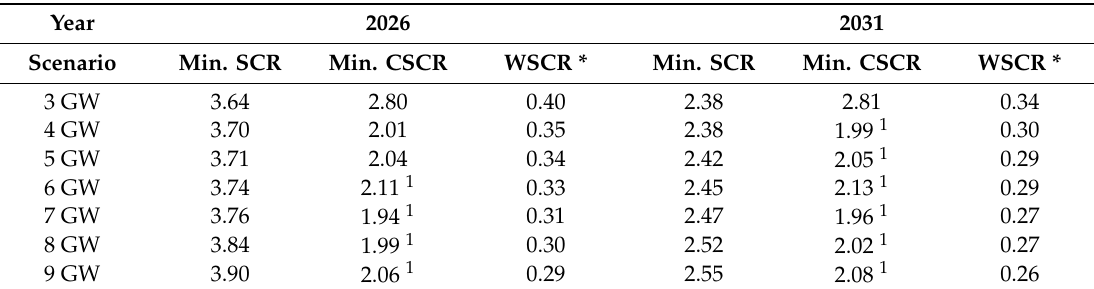
Table 9. Robustness analysis results for 2026 and